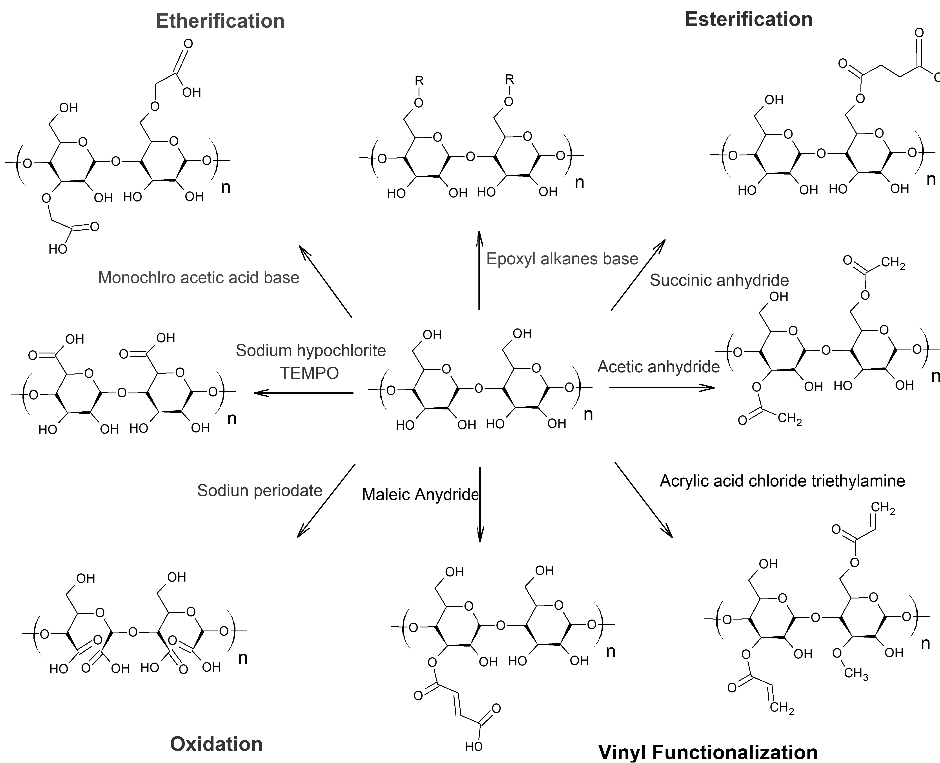
Processes 2019 , 7 , x FOR PEER REVIEW Figure 4. Some examples of starch modification by small molecule chemistry. Figure 4. Some examples of starch modification by small molecule chemistry.